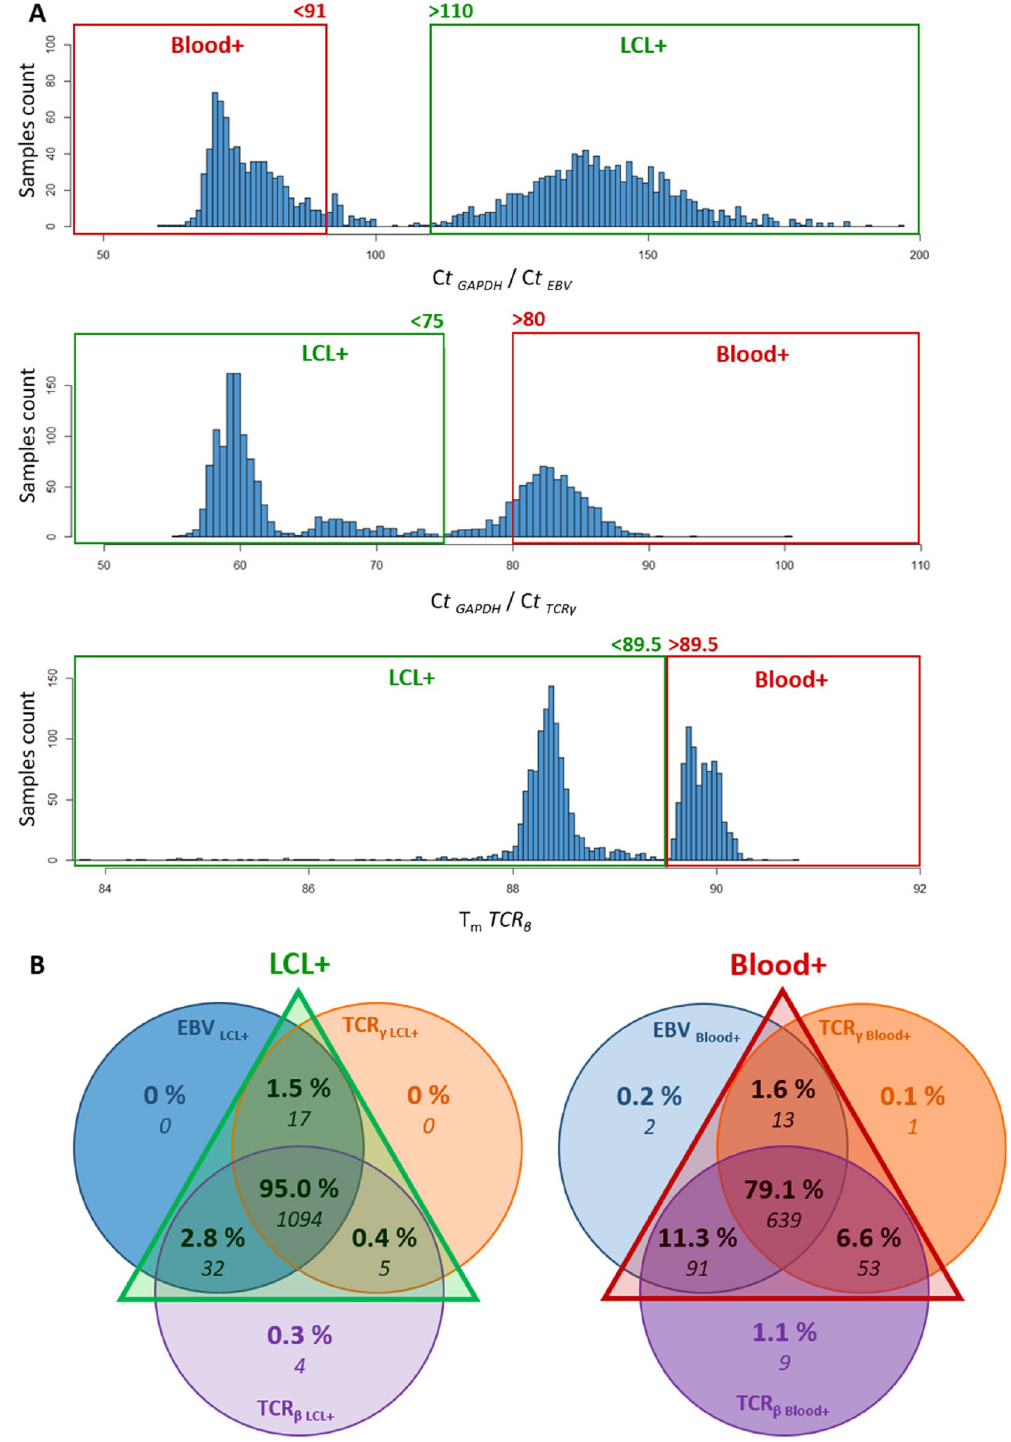
Figure 3. Application of the three tissue-of-origin real-time PCR assays to DNA samples (n = 1957) of the CEPH Aging cohort. ( A ) Distribution of C t EBV /C t GAPDH ratios, C t TCRγ /C t GAPDH ratios and mean TCR β T m of CEPH Aging cohort DNA samples based on EBV , TCR γ and TCR β real-time PCR assays. ( B ) Venn diagrams of the results using the combination of the three real-time PCR assays: EBV , TCR γ and TCR β . When there was a discrepancy between the results of the three tests, the samples were represented on both the left and right Venn diagrams. The percentages were calculated from the total number samples present in each Venn Diagram (1152 for the left and 808 for the